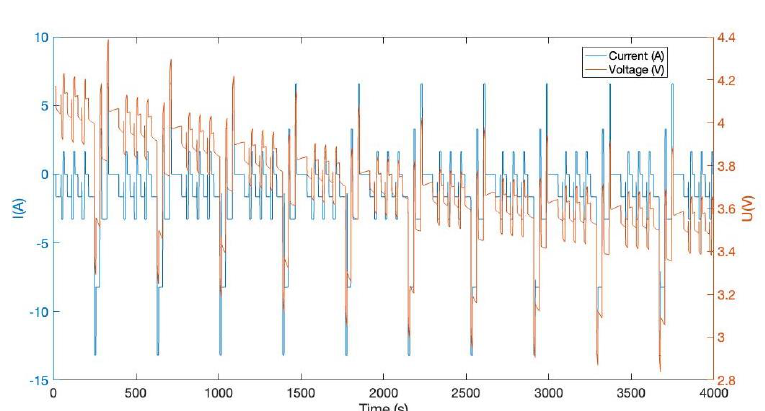
Figure 23. Battery current and voltage changes in the DST